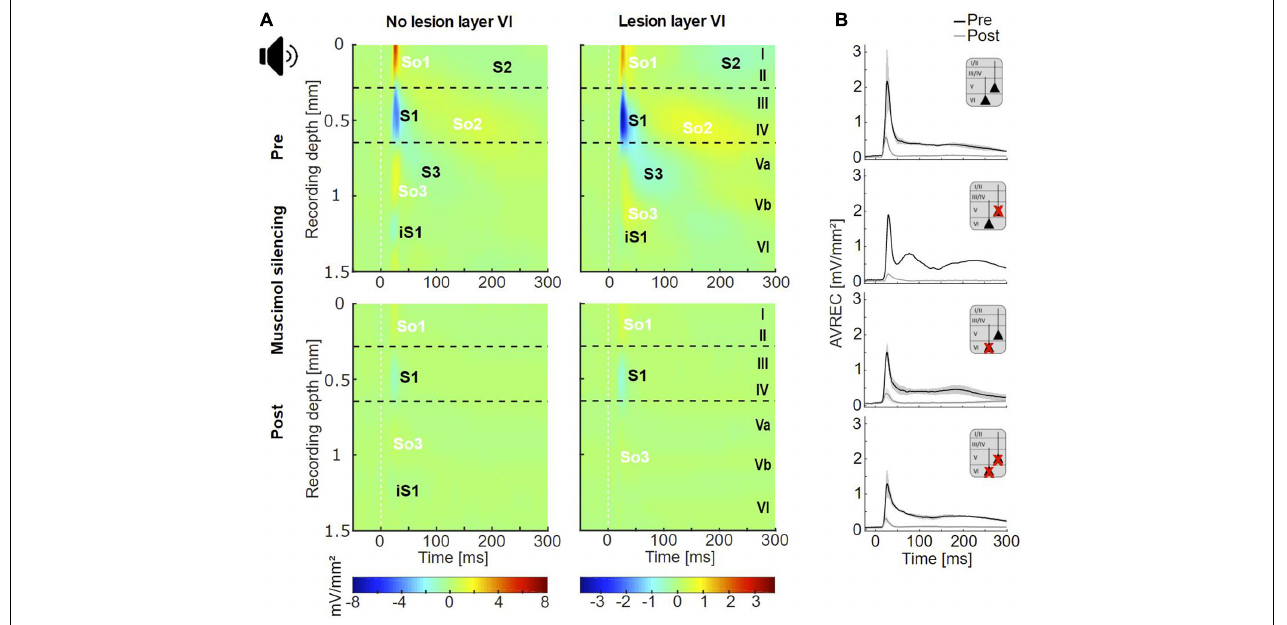
FIGURE 3 | Cortical responses evoked by acoustic stimulation. (A) Averaged acoustically evoked CSD profiles at BF (54 dB SPL), before (top), and after (bottom) cortical silencing with muscimol. The grand mean of cases without lesions in layer VI (lesion groups non-Les and LesV, n = 7) and that of cases with layer VI lesions [groups LesVI and LesV+VI, n = 10 (pre), 9 (post)] had comparable general activation patterns of current sinks (S1, S2, S3, iS1) and sources (So1, So2, So3), shown in blue and yellow/red, respectively. Animals without layer VI lesions displayed a stronger early infragranular sink (iS1). (B) Averaged AVREC traces at BF before (black) and after (gray) cortical silencing showing means (solid lines) and SEM (shaded areas) of the four lesion groups. Curves were similar across all groups. n non − Les = 6, n LesV = 1, n LesVI = 4; n LesV + VI = 6 (pre), 5